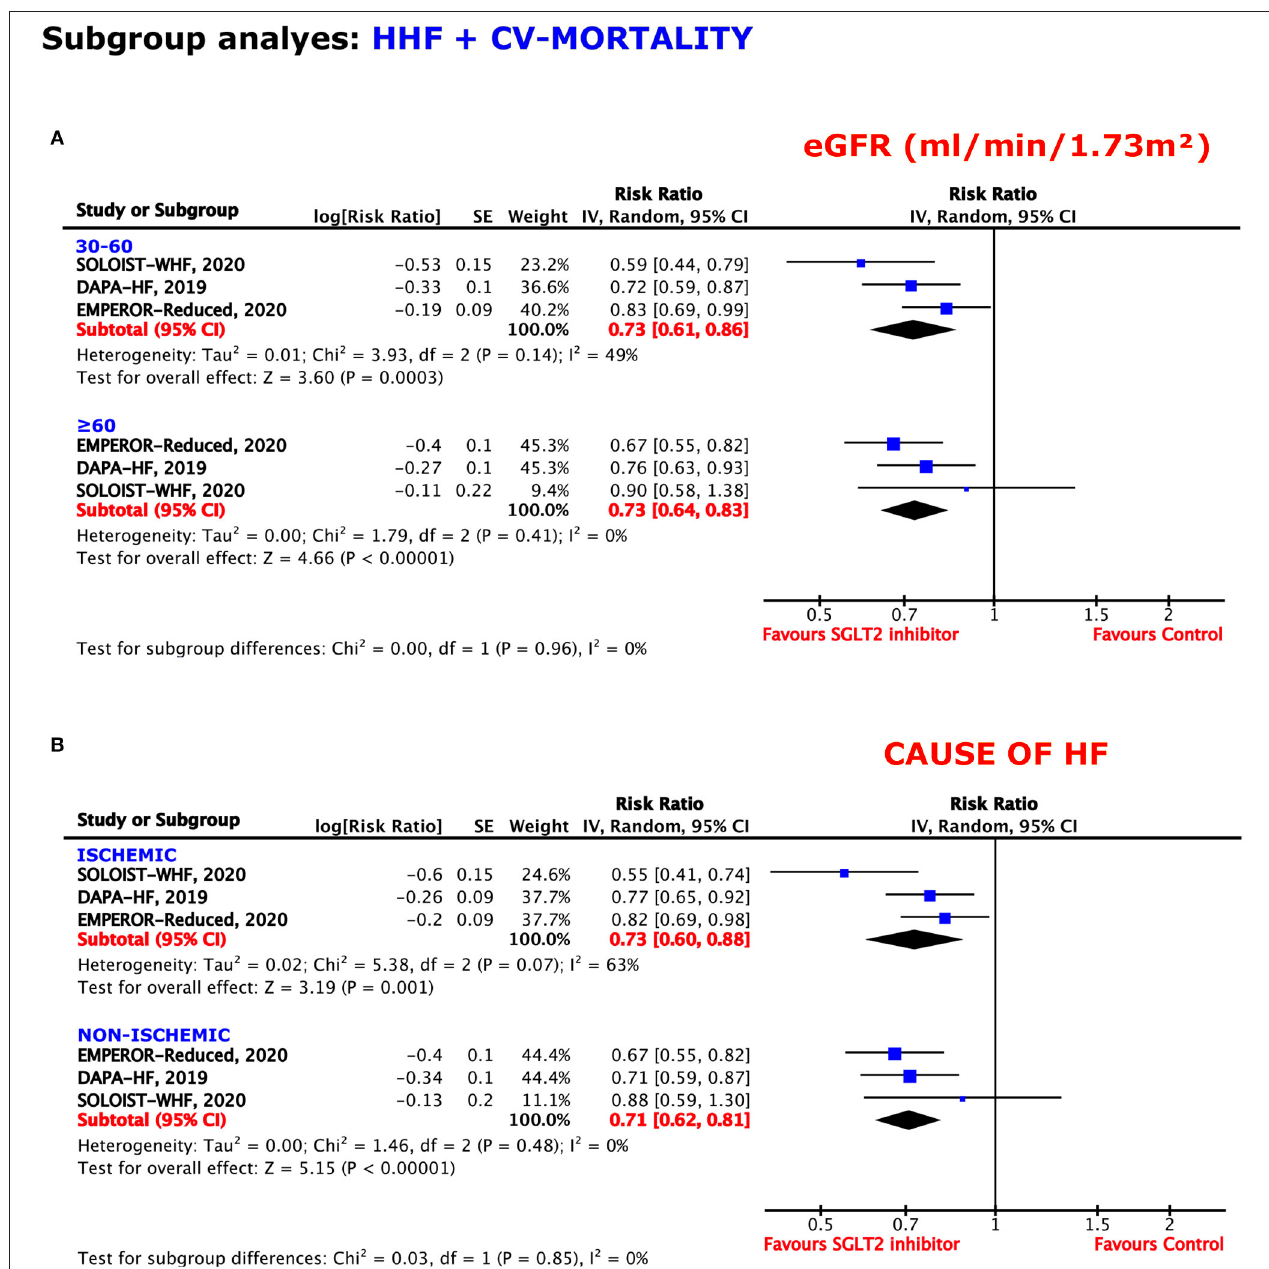
FIGURE 6 | Subgroup analyses for the composite outcome according to the (A) estimated glomerular filtration rate (eGFR) and (B) cause of HF.